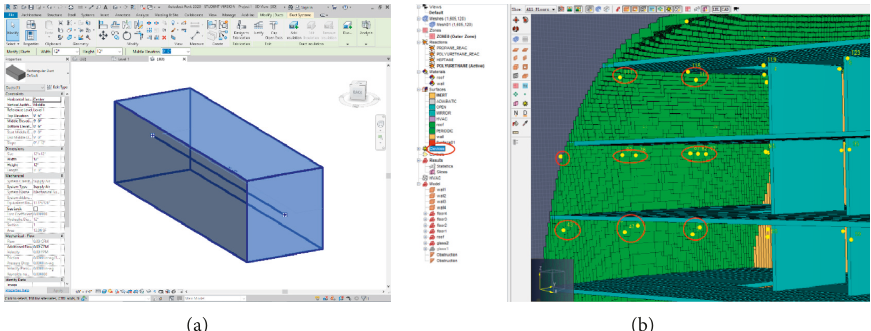
Figure 17: (a) The ventilation in Revit building model. (b) The thermocouple in FDS model.